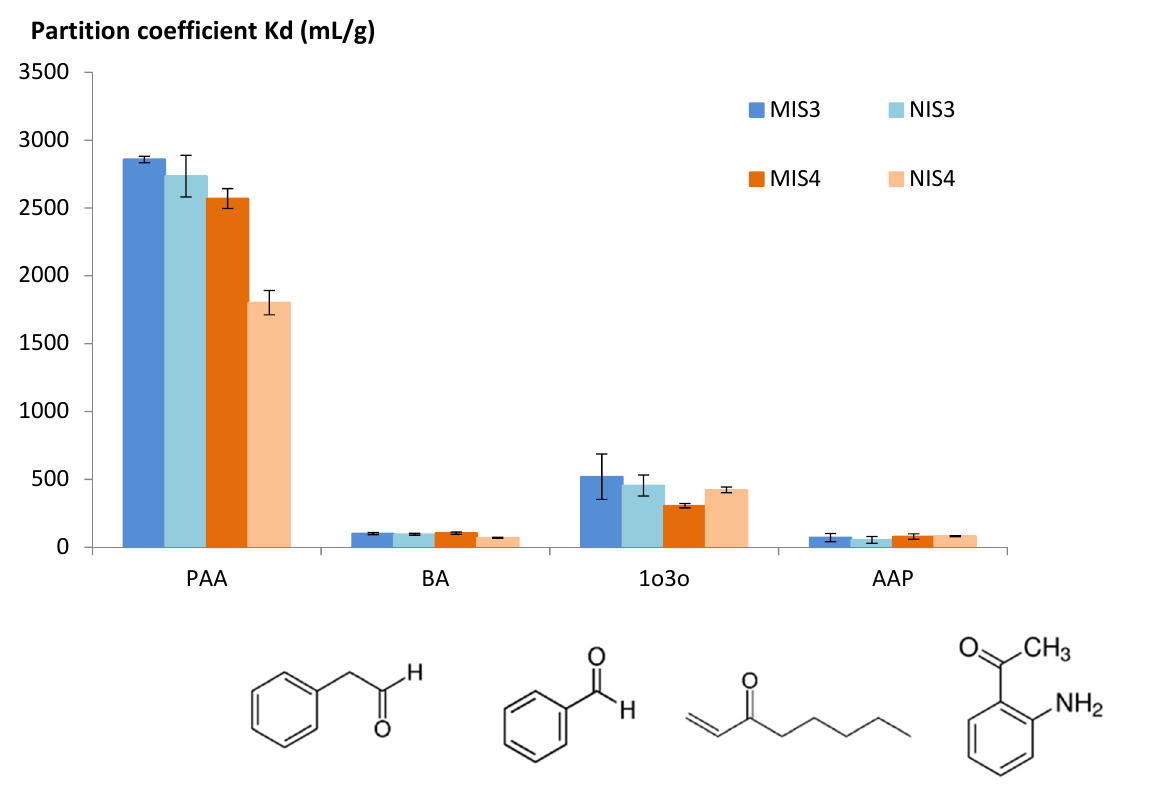
Figure 2. Partition coefficient in water/EtOH (90/10; v / v ). Phenylacetaldehyde (PAA), Benzaldehyde (BA), 1-octen-3-one (1o3o) and 2-aminoacetophenone (AAP). Error bars represent standard deviation.